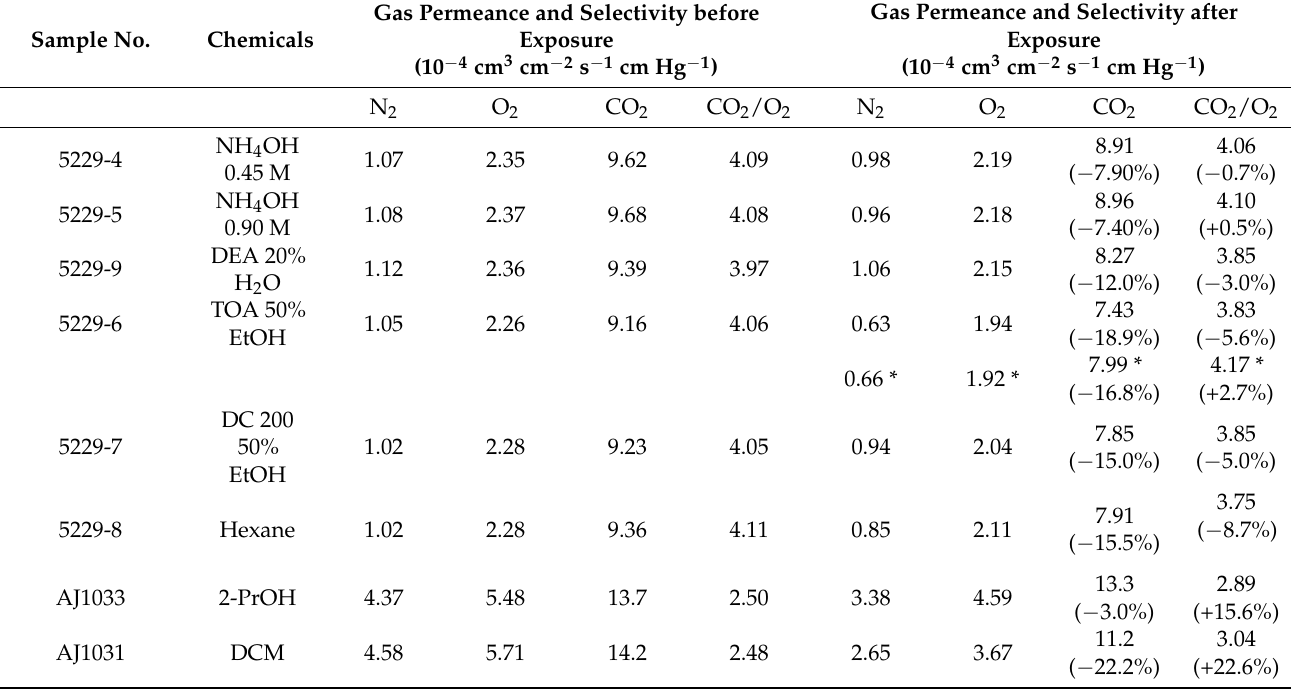
Table 17. Changes in gas permeability characteristics on exposure to